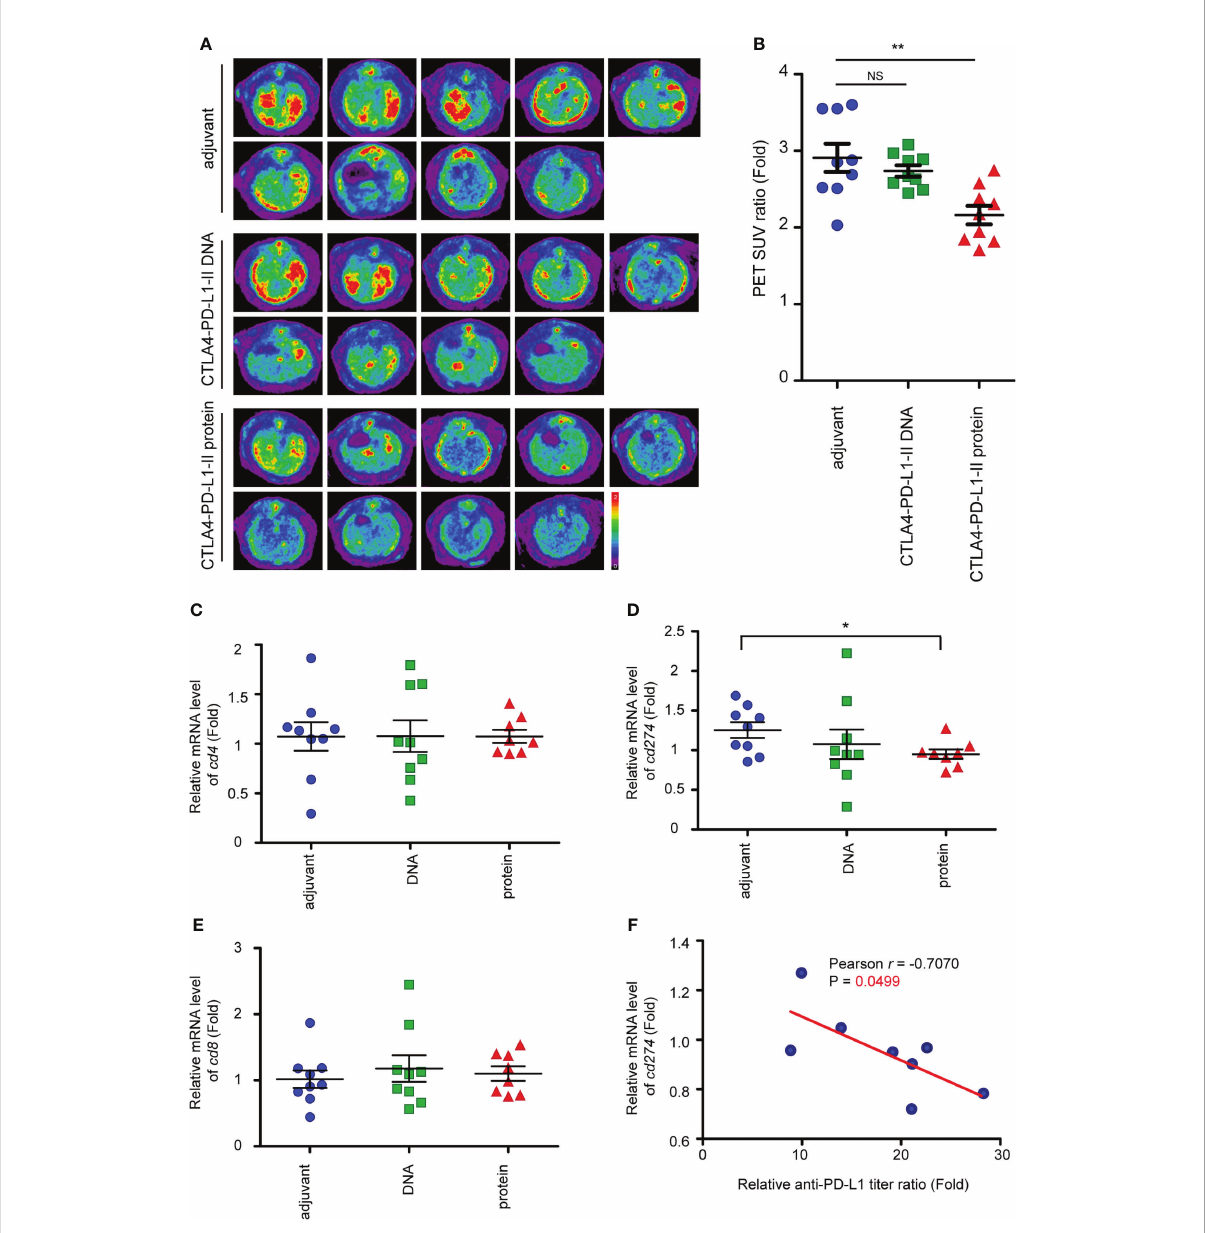
FIGURE 4 Reduced of iCCA tumorigenesis after CTLA4-PD-L1-II chimeric protein vaccination. (A) Representative image of 18F-FDG microPET on TAA- induced CCA in SD rats. The images were performed at week 45 after the treatment of CTLA4-PD-L1-II DNA, chimeric protein, or control adjuvant. (B) The tumor-to-liver ratio of SUV in the control adjuvant and experimental groups at 45 after the vaccination. The values are presented as the mean ± SEM. N=9. **P< 0.01 by Mann – Whitney U tests. NS, not signi fi cant. (C – E) The mRNA expression levels of cd4 (C) , cd8 (D) , and cd274 (E) in the tumors from the rats receiving the vaccination of CTLA4-PD-L1-I DNA or CTLA4-PD-L1-I protein, or control adjuvant. The values (means ± SEM) are presented as the fold-change relative to the average level of the tumors from the rats receiving control adjuvant. N=9.*P < 0.05 by Student ’ s t -test. (F) The correlation between the anti-PD-L1 antibody titer ratio and the relative mRNA level of CD274 . The correlation Pearson coef fi cient r and P values are shown in the panel.